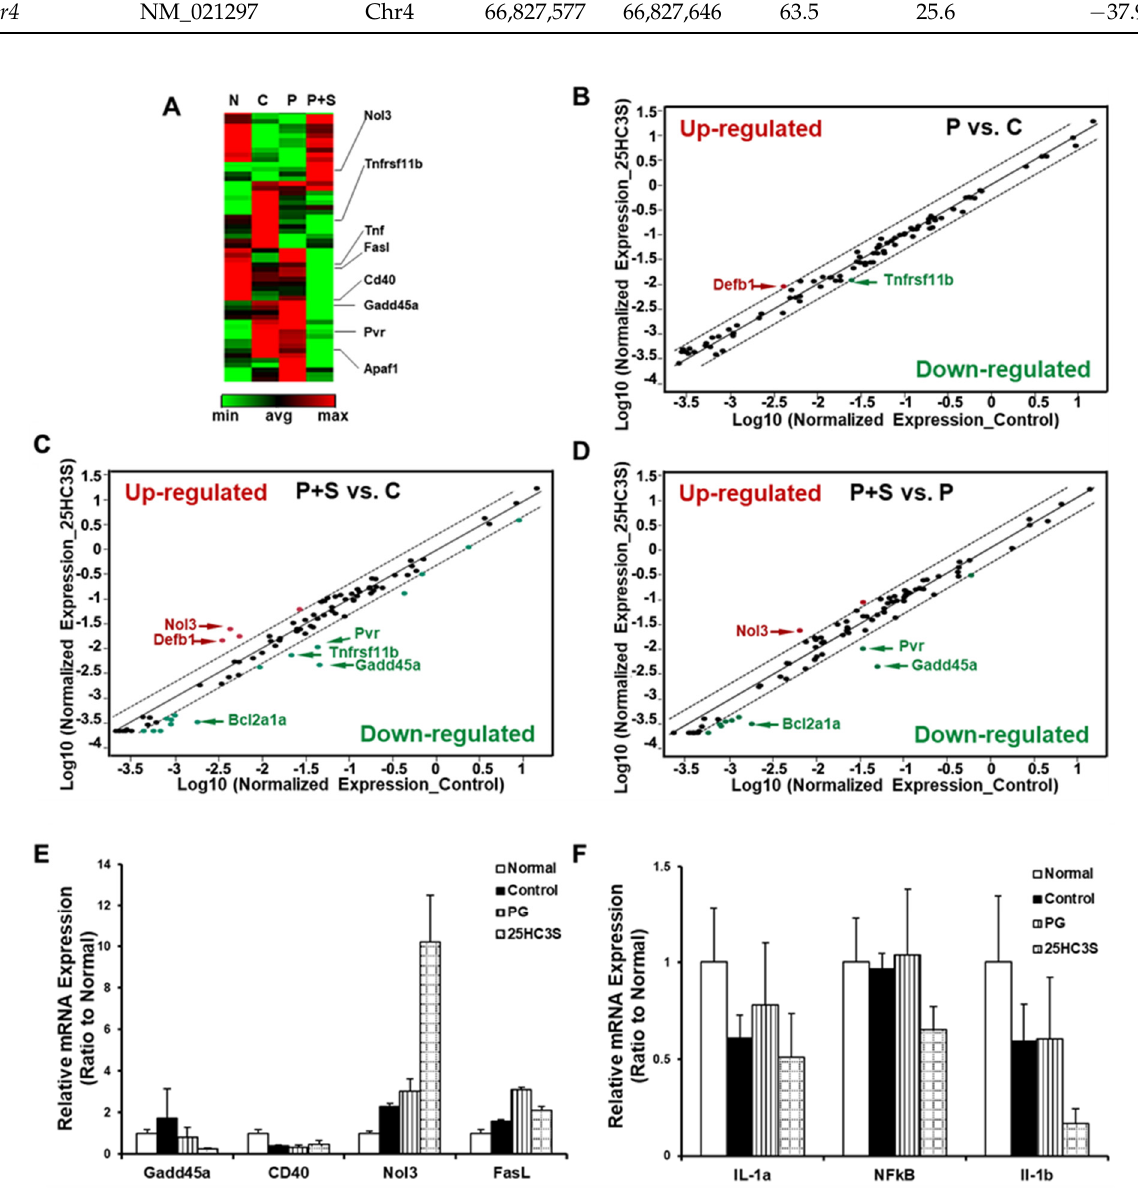
Figure 3. 25HC3S treatment regulates expression of apoptosis-related genes in the liver tissues of APAP overdose